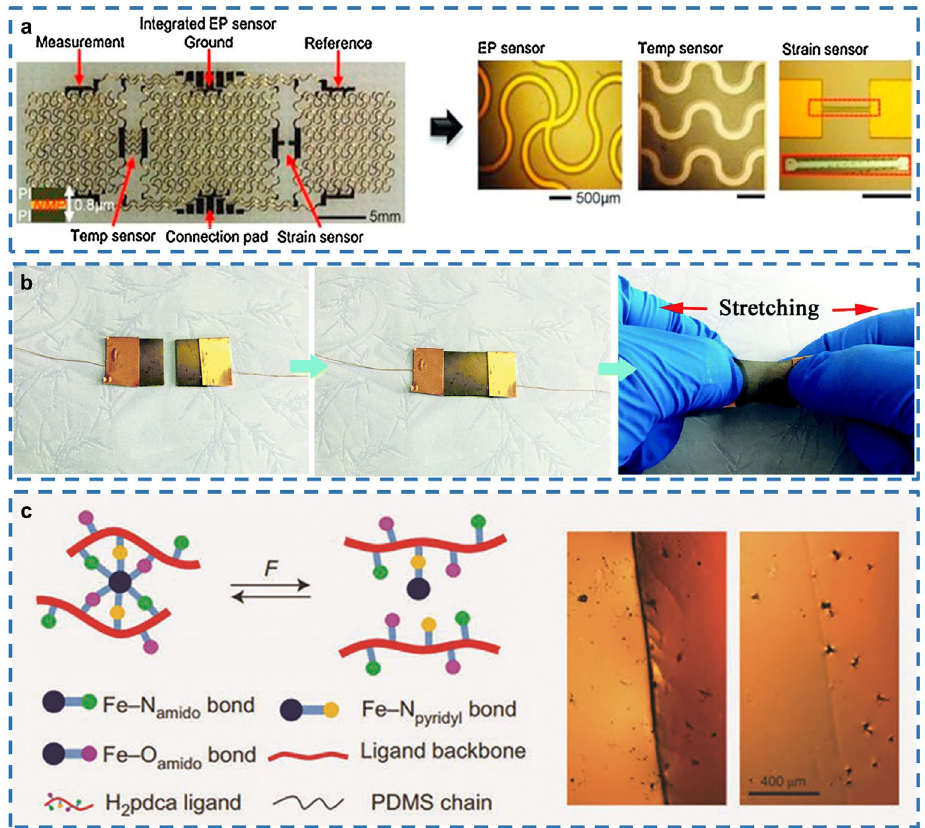
Figure 4. Self-healing e-skin devices. ( a ) A multifunctional epidermal electronic system. Reprinted with permission from [116]. Copyright 2017, Elsevier. ( b ) Stretchable and self-healable electrical sensors for surface texture discernment and biosignal monitoring. Reprinted with permission from [117]. Copyright 2019, WILEY-VCH. ( c ) Autonomous self-healing elastomer using metal coordination. Reprinted with permission from [118]. Copyright 2019, The Royal Society of Chemistry.